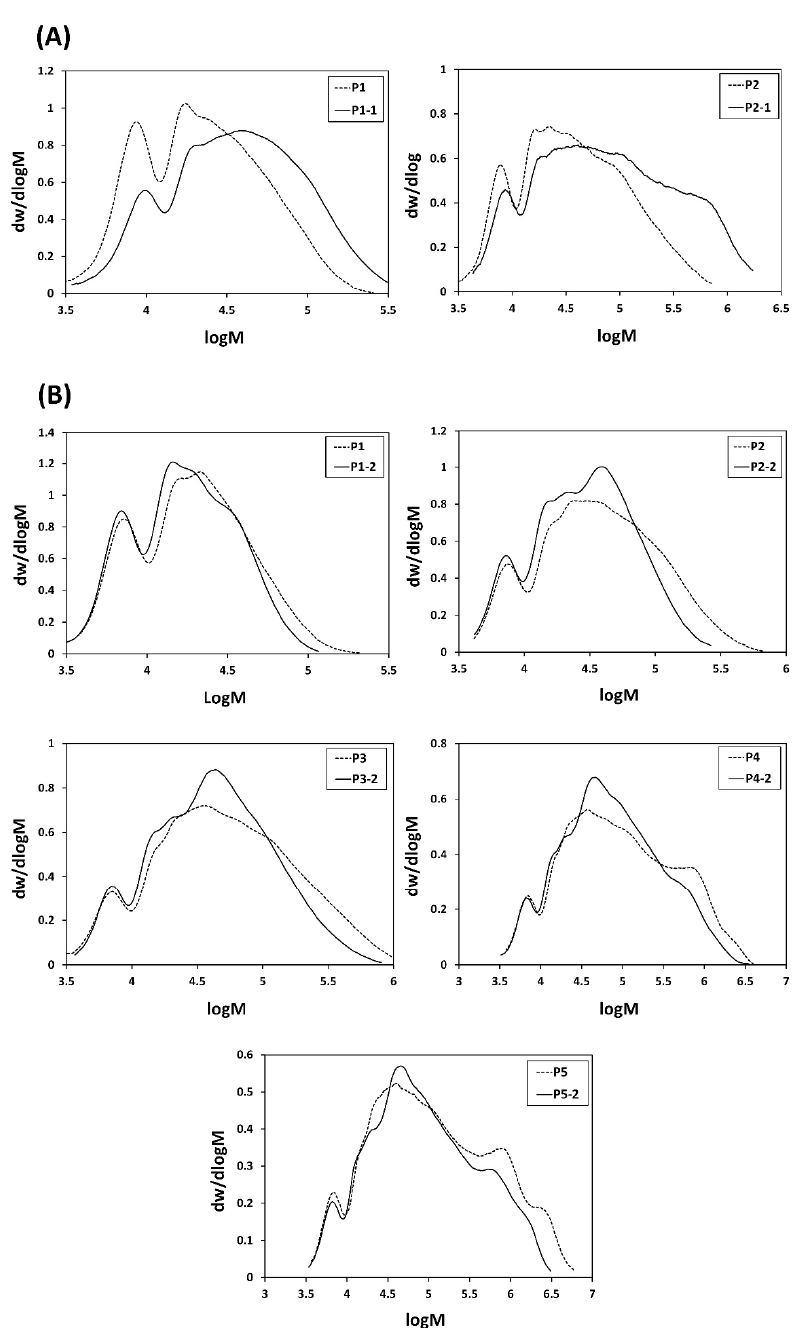
Figure 3. DMF GPC molecular weight distributions of HBPs before (dotted lines) and after aminolysis/HEA conjugation (plain lines) ( A ) in the absence Me 2 PPh, and ( B ) in the presence of Me 2 PPh.